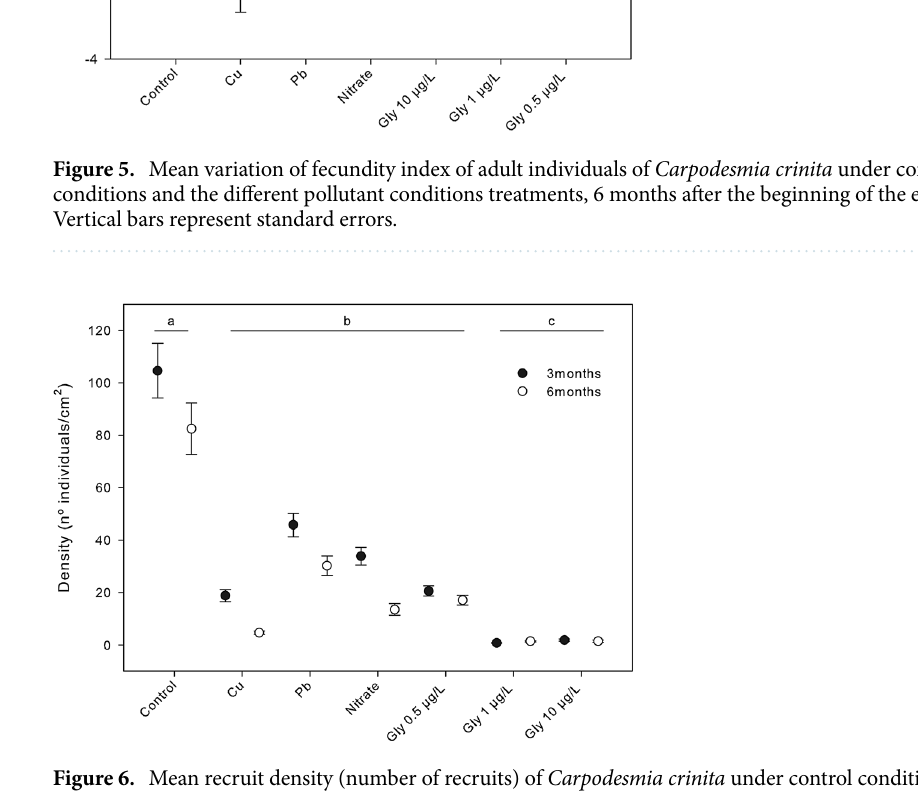
Figure 6. Mean recruit density (number of recruits) of Carpodesmia crinita under control conditions and the different pollutant treatments at 3 months and 6 months after the beginning of the experiment. Vertical bars represent standard errors. Horizontal lines ( a , b and c ) indicate significant differences between